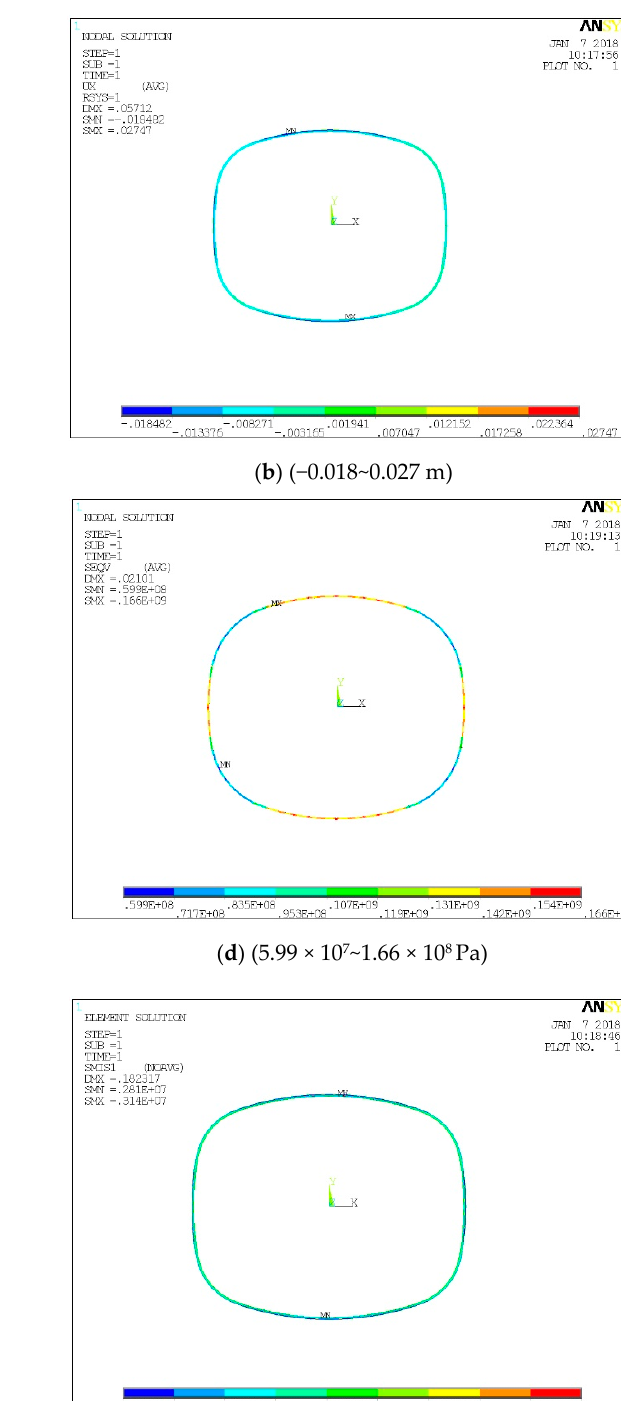
radial cable forces (N); ( f ) tension ring cable forces (N).